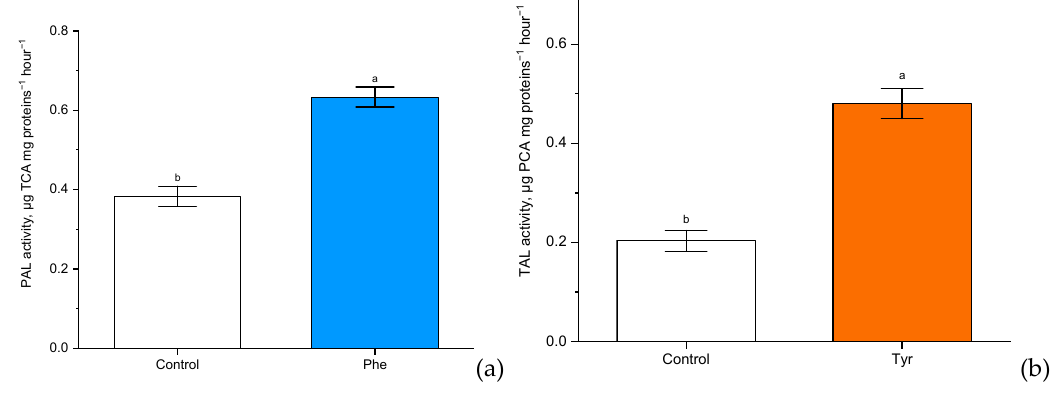
Figure 5. The activity of phenylalanine ammonia-lyase (PAL) ( μ g trans-cinnamic acid (TCA) mg proteins − 1 h − 1 ) ( a ) and tyrosine ammonia-lyase (TAL) ( μ g p-coumaric acid (PCA) mg proteins − 1 h − 1 ) ( b ) in wheat samples incubated on the nutrient medium supplemented with 500 μ M of phenylalanine and tyrosine respectively, for 4 h. Bars marked with different letters show significant differences at ( p ≤ 0.05) according to Tukey’s test.